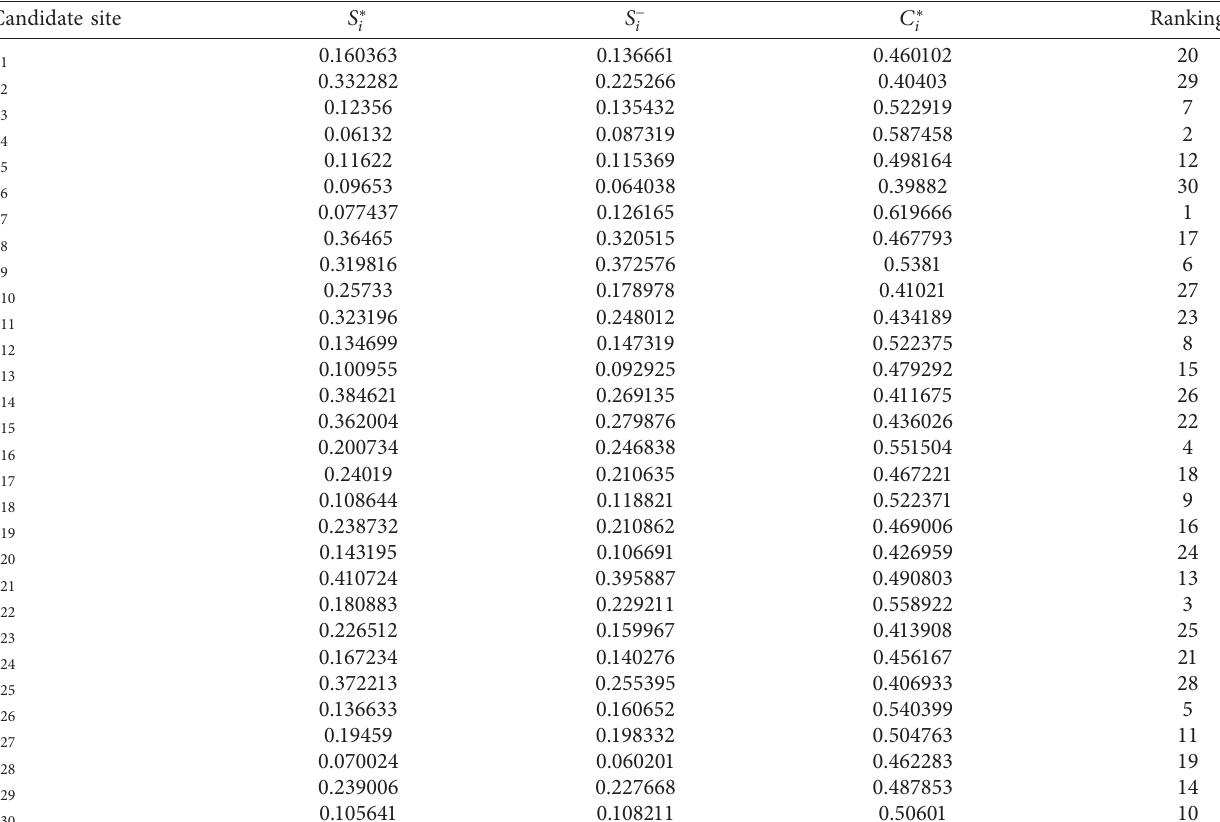
Table 3: Distance between evaluation vectors and positive and negative ideal solutions and the fitting degree. Candidate